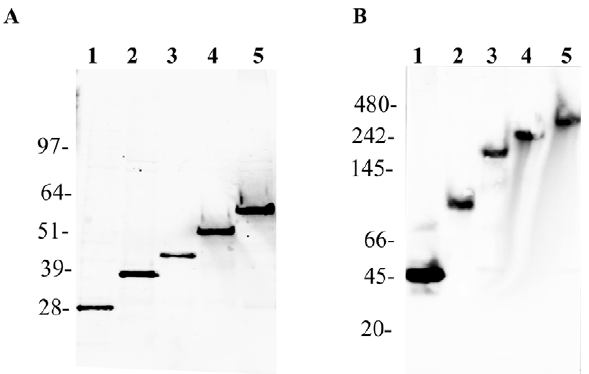
Figure 4. Western Blot analysis of lysates from cells transfected with Htt fragments. A. Western blot of GFP and different